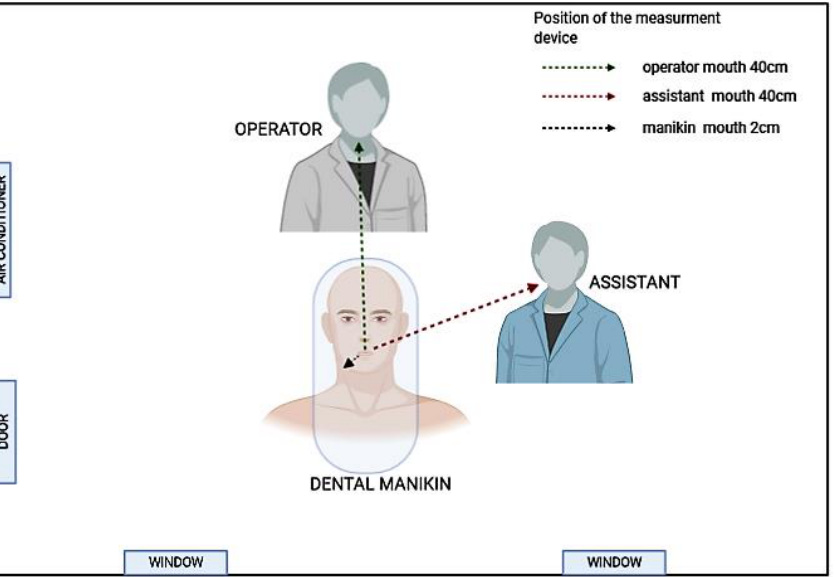
Figure 2. Measurement sites and positions of the sensor.